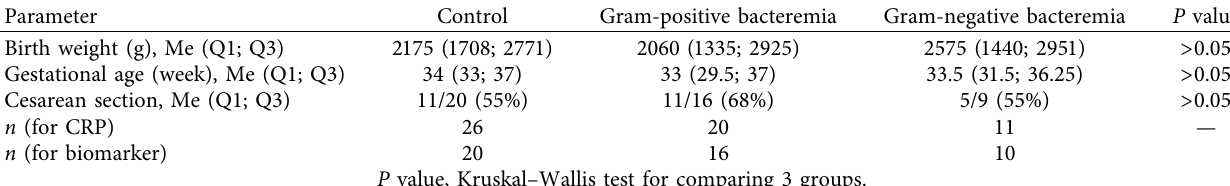
Table 1: Patient information.